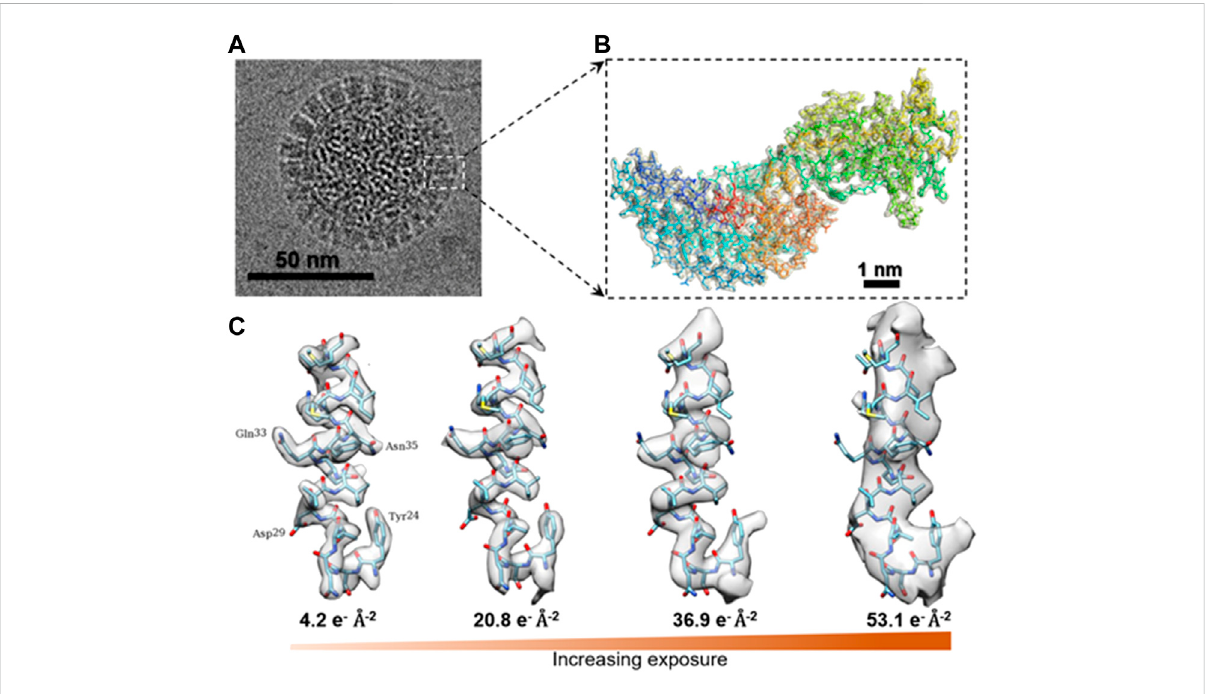
FIGURE 4 Cryo-EM 3D structure of rotavirus VP6 under different dose. (A) Aligned image of the rotavirus double-layered particle (DLP) imaged by cryo- EM. (B) Density of an isolated VP6 subunit is shown as a mesh along with the docked atomic model. The model is colored in blue for the N-terminus and in red for the C-terminus. (C) Surface rendering of an isolated small helix, in which the density of side chains fades with increasing exposure and dose deposited on the sample. Reproduced with permission (Grant and Grigorieff,